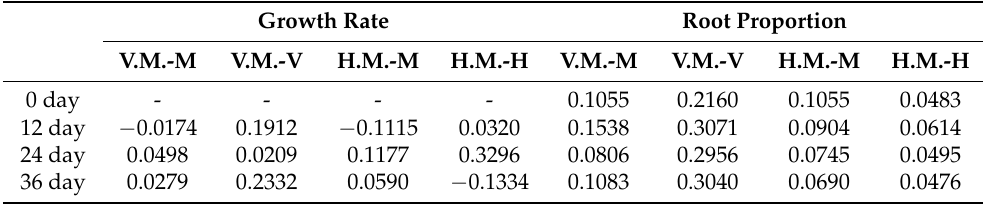
Table 3. Plant growth rate and root proportion in different